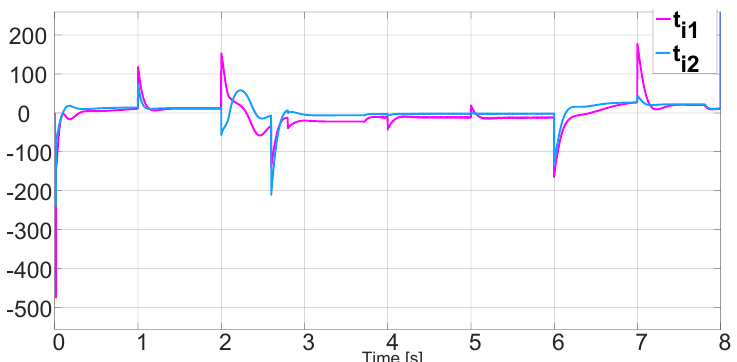
Figure 8. Impedance controller